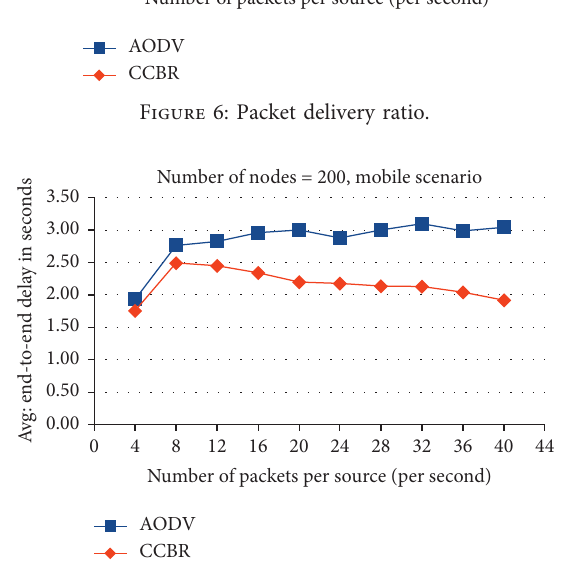
Figure 7: End-to-end delay.